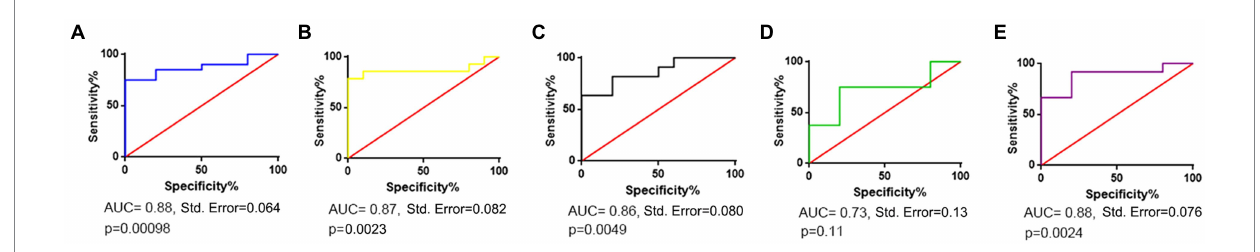
FIGURE 6 Receiver operating characteristic (ROC) curve corresponding to differences between each disease group and the healthy control group. (A) ILD vs. HC; (B) BP vs. HC; (C) FP vs. HC; (D) AS vs. HC; (E) LC vs. HC.